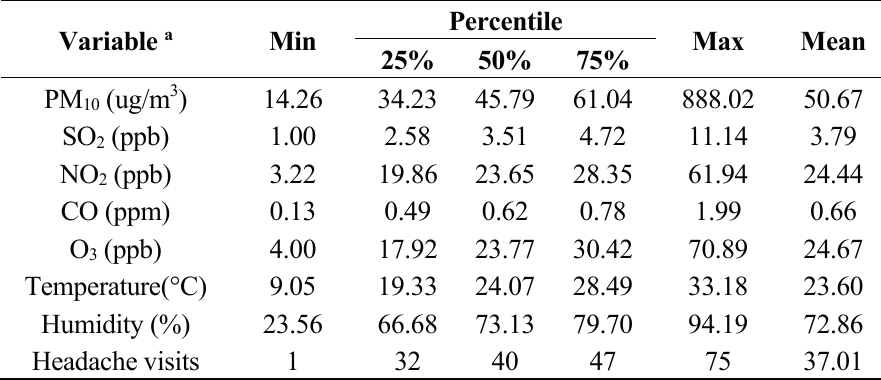
Table 1. Daily clinic visits for headaches, weather, and air pollution variables in Taipei, Taiwan,